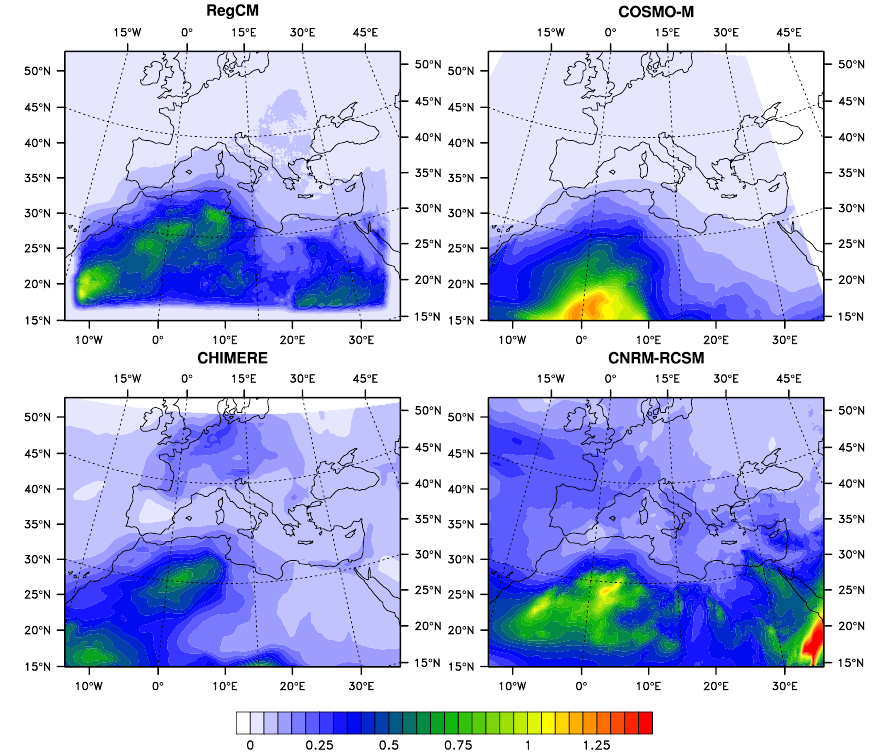
Figure 30. AOD averaged for the 15 to 25 June 2013 period from the models RegCM, COSMO-MUSCAT, CHIMERE and CNRM-RCSM. Details about the model configurations are provided in Table